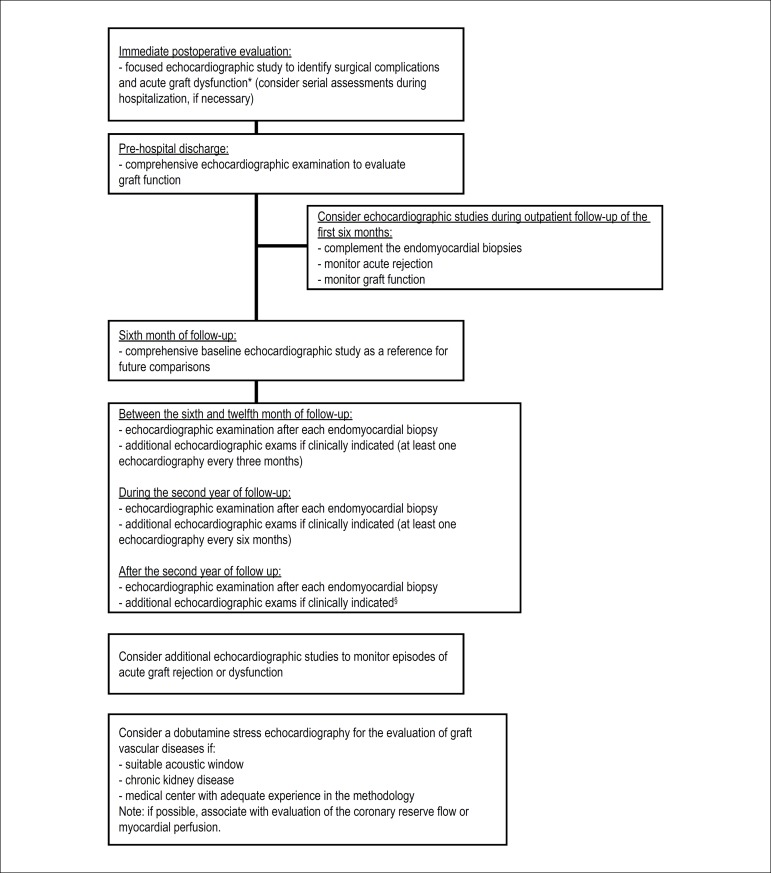
Echocardiographic evaluation after cardiac transplantation.*Graft dysfunction: confirmed on echocardiographic
examination by dropping the ejection fraction by more than 10%
to a value lower than 50%, compared to the baseline examination
of the sixth month; §patients with graft
dysfunction suspected or confirmed; clinical symptoms of a
possible new cardiac abnormality; alterations in the resting
electrocardiogram.